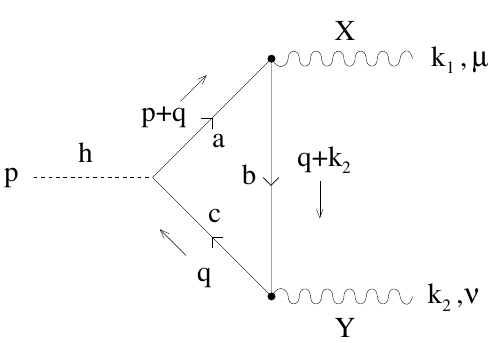
Figure 5 . Loop diagram for h ! XY decay due to the fermion loop f abc g